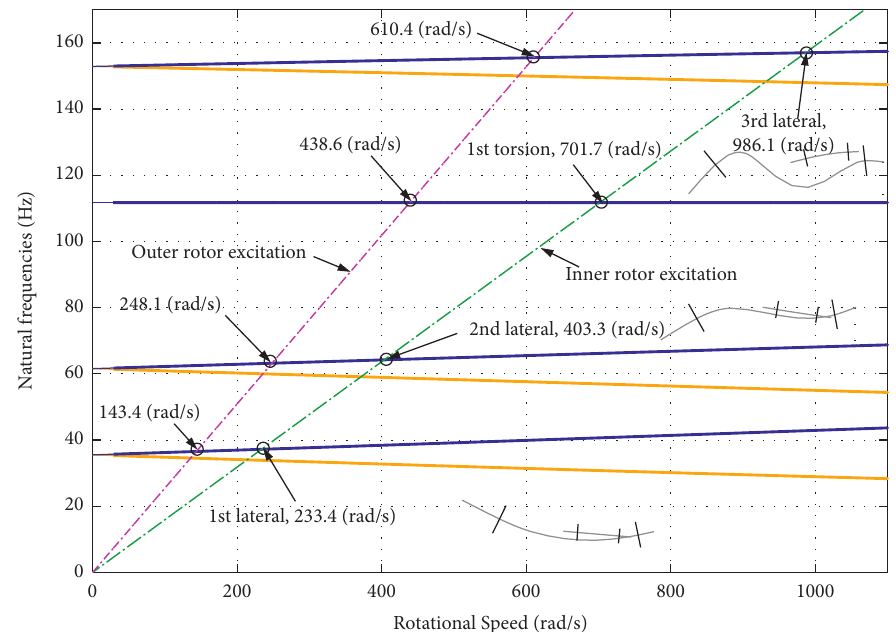
Figure 5: Campbell diagram of the dual-rotor system. Table 6: Parameters of the level and hovering flight. Actions